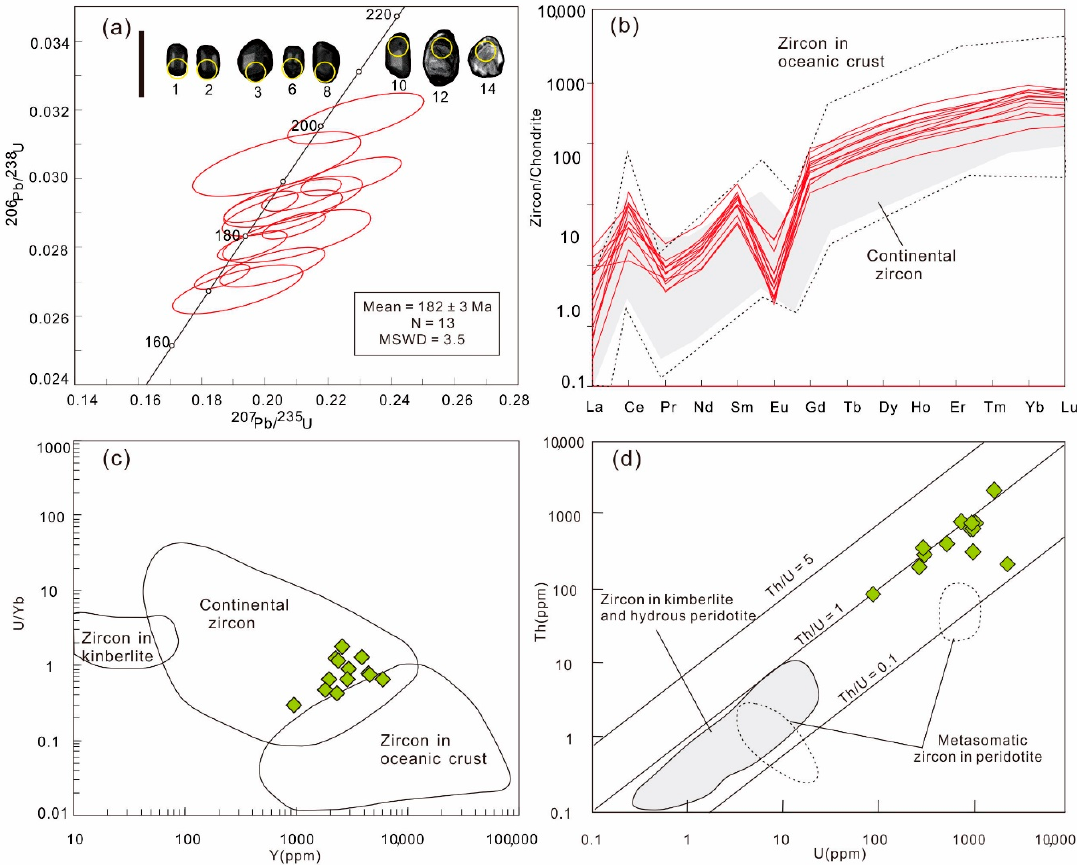
Figure 3. ( a ) Zircon U–Pb concordant diagram and representative cathodoluminescence images; ( b ) chondrite-normalized REE patterns of zircon grains (composition of chondrite according to Sun and McDonough [31]); ( c ) zircon Y versus U/Yb diagram (based on Grimes et al. [32]); ( d ) zircon U versus